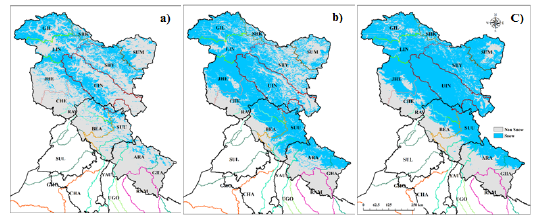
Figure 5. Overall variation in SCA in NWH from 2000-2018.